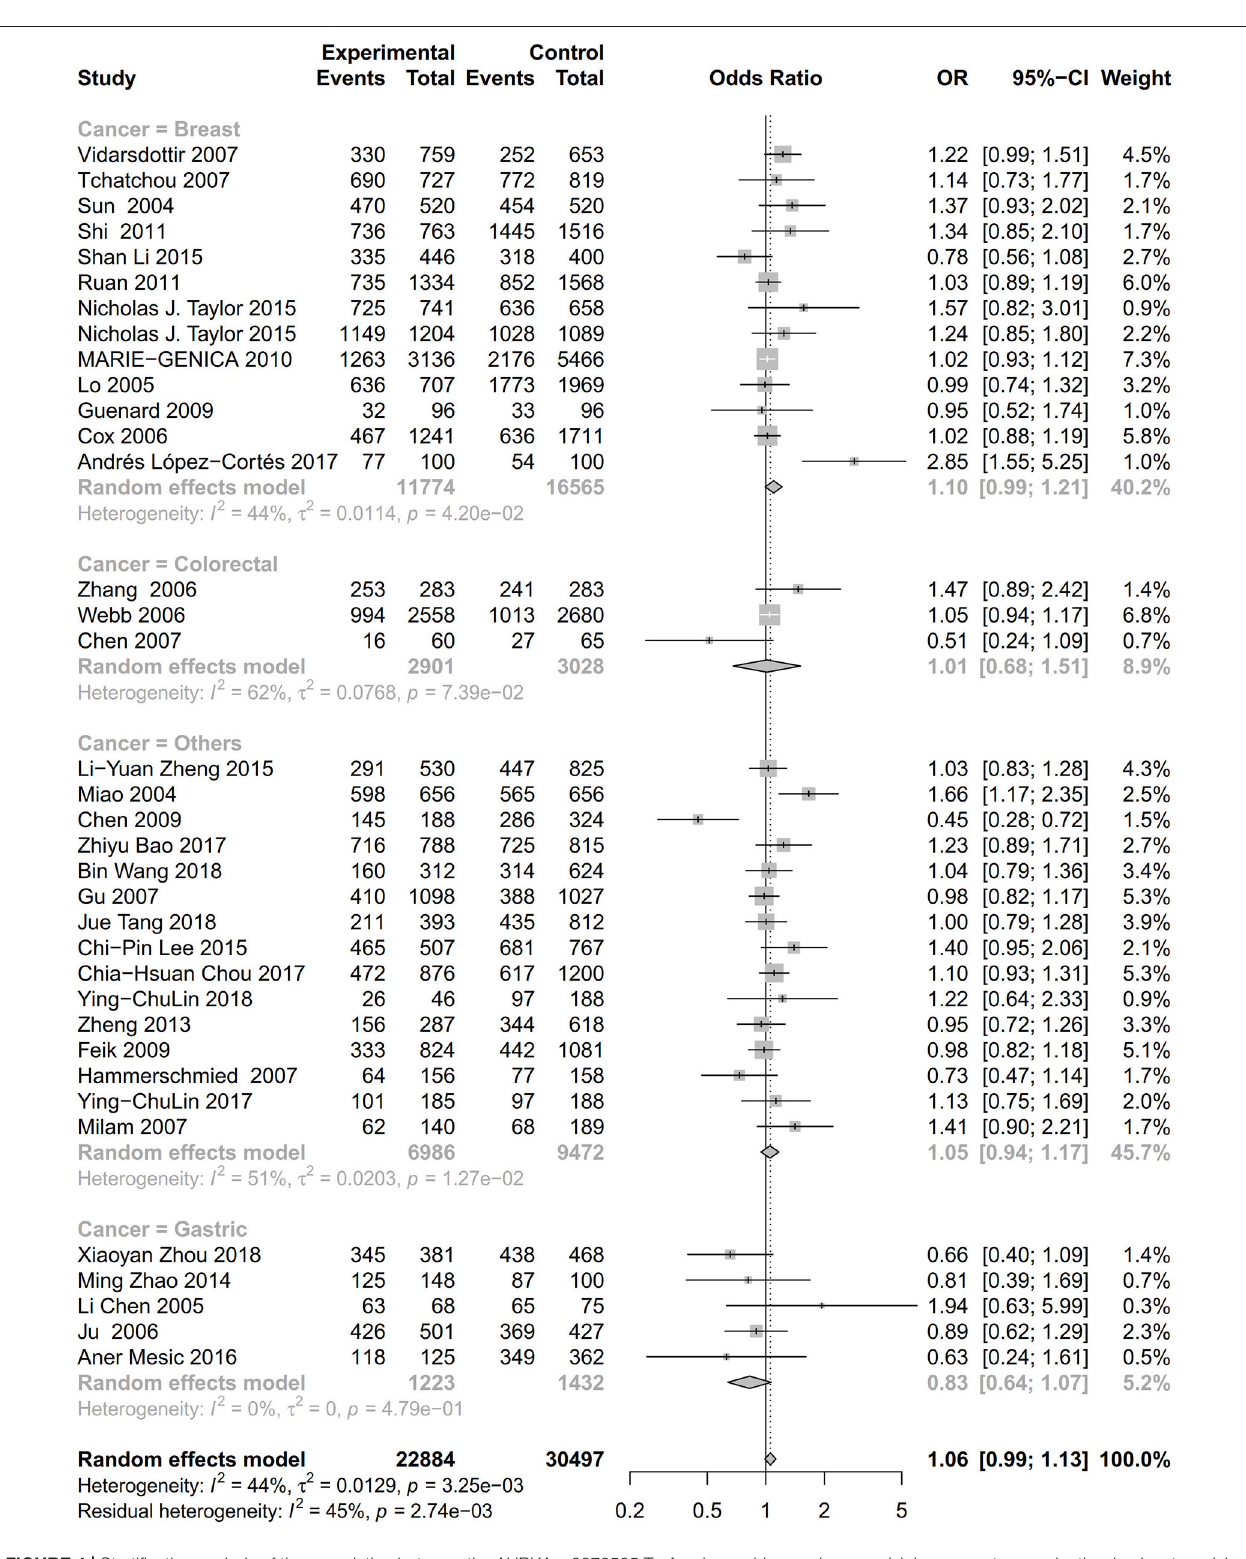
Frontiers in Oncology |